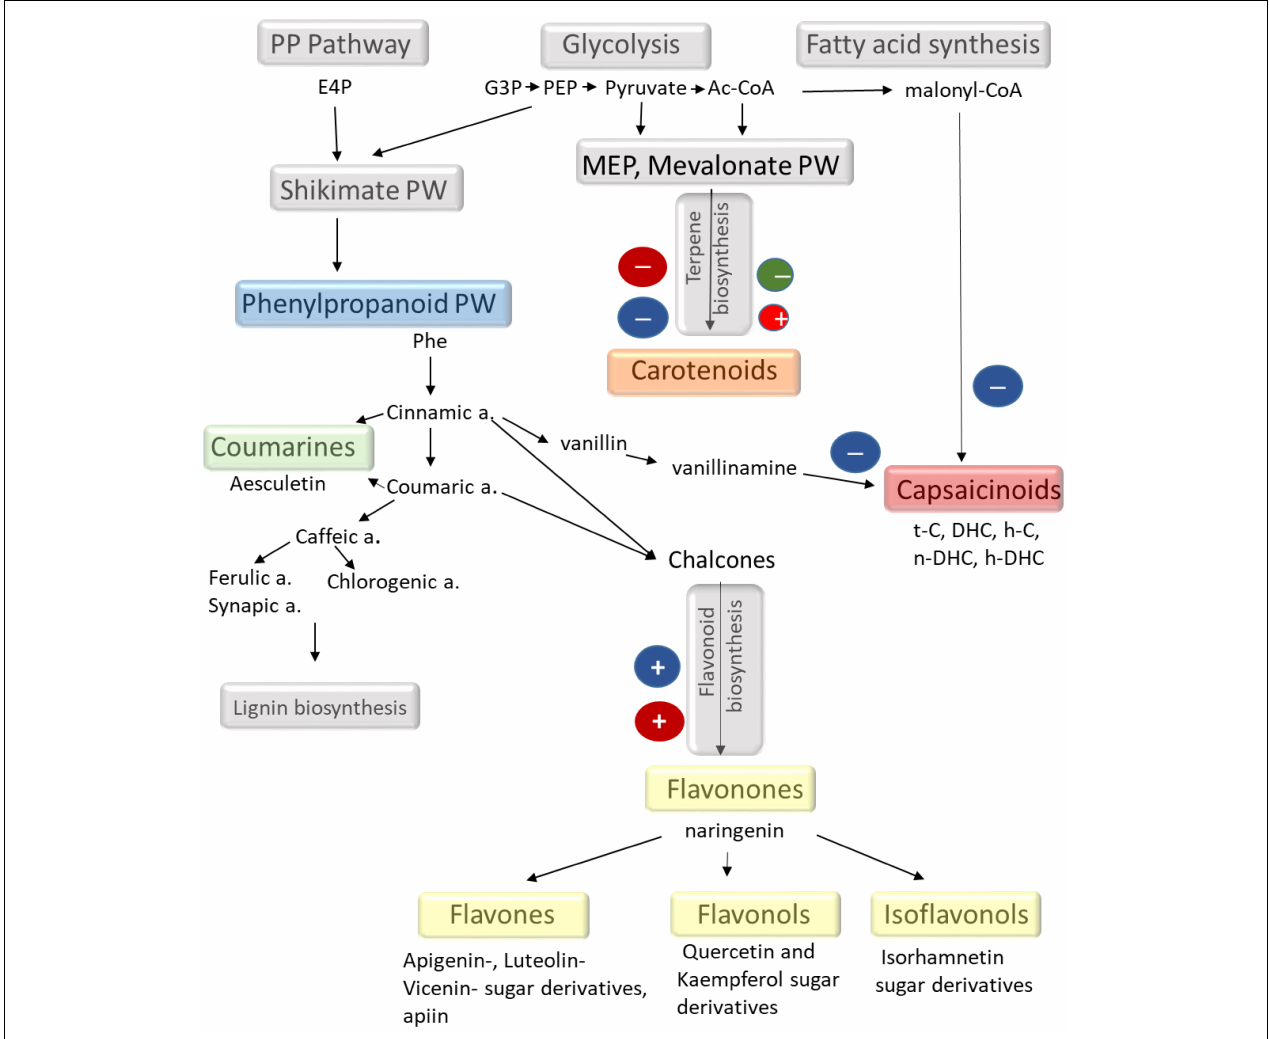
FIGURE 5 | Schematic representation of different secondary metabolic pathways focusing on the metabolites found in the chilli fruit. The effects of light observed in the present experiments are also indicated. The scheme is based on the KEGG database (maps 00998, 00941, 00940, and 01060).